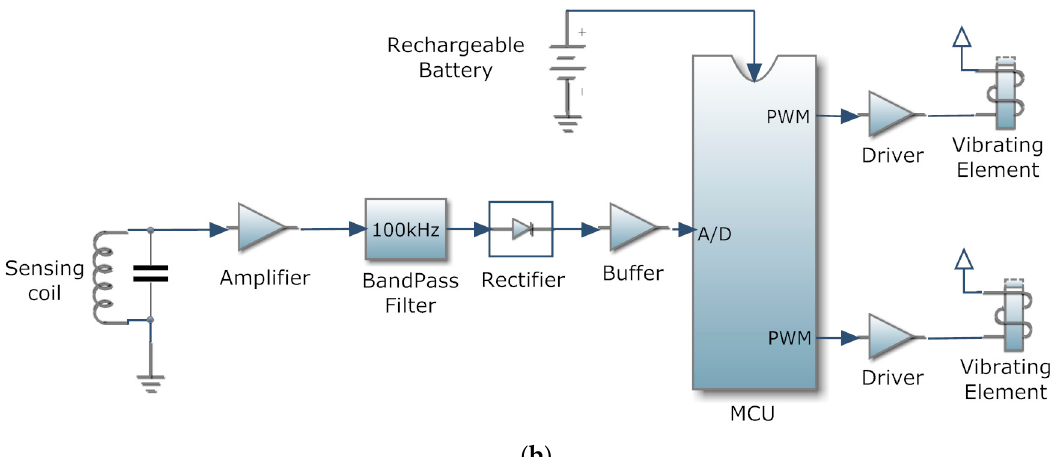
Figure 3. ( a ) A picture of the receiving system; ( b ) Block diagram of the receiving circuit: The analog signal detected by the coil is amplified, filtered, and rectified. The microcontroller (MCU) converts the signal into a digital sequence, whose peaks are evaluated and used to drive the vibration motors placed on both arms of the runner. PWM: pulse width modulation.